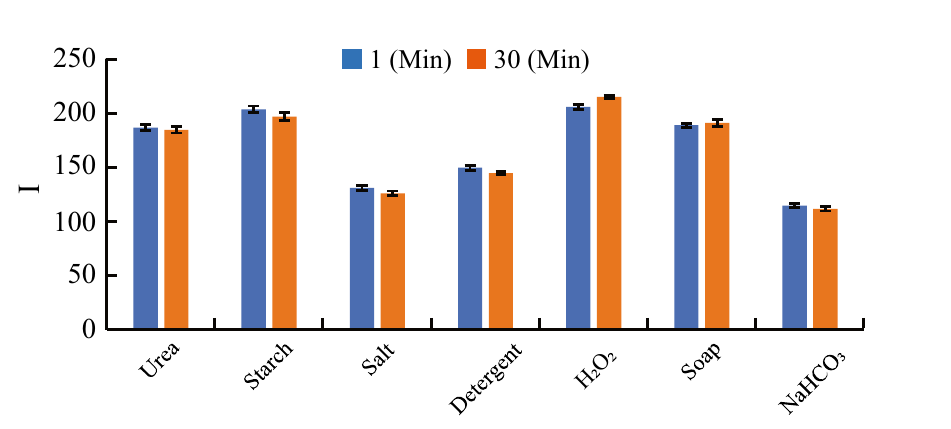
Figure 3. The color intensity values of the detection zones are shown here for 1 min and 30 min.